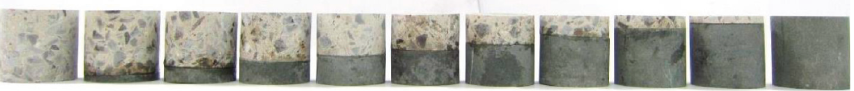
Figure 1: Processing prepared combined bodies.